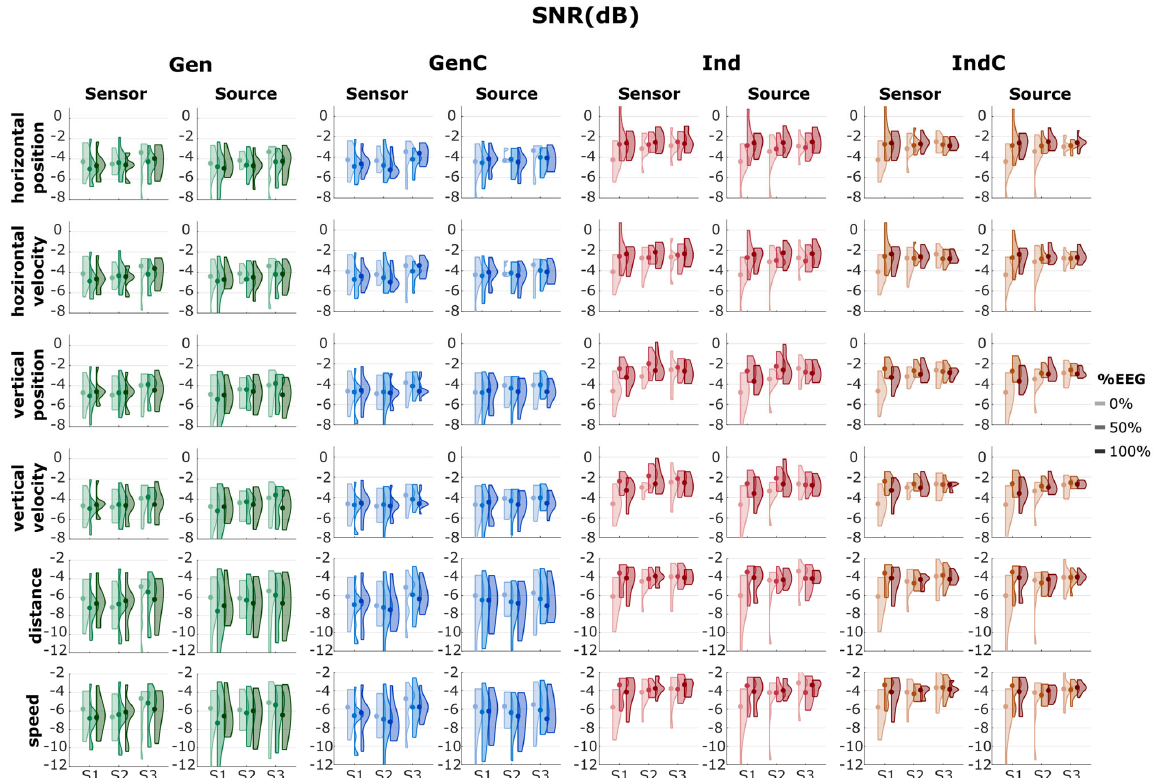
Figure 4. Plots of the distribution of SNRs from 4 different scenarios: Gen, GenC, Ind, and IndC, indicated by di ff erent colors. The lightness of the color indicates the measurement block, either 0%, 50%, or 100% EEG from sessions 1, 2, and 3, indicated as S1, S2, and S3, respectively. The corresponding median SNRs and their standard deviations are summarized in Table S2.